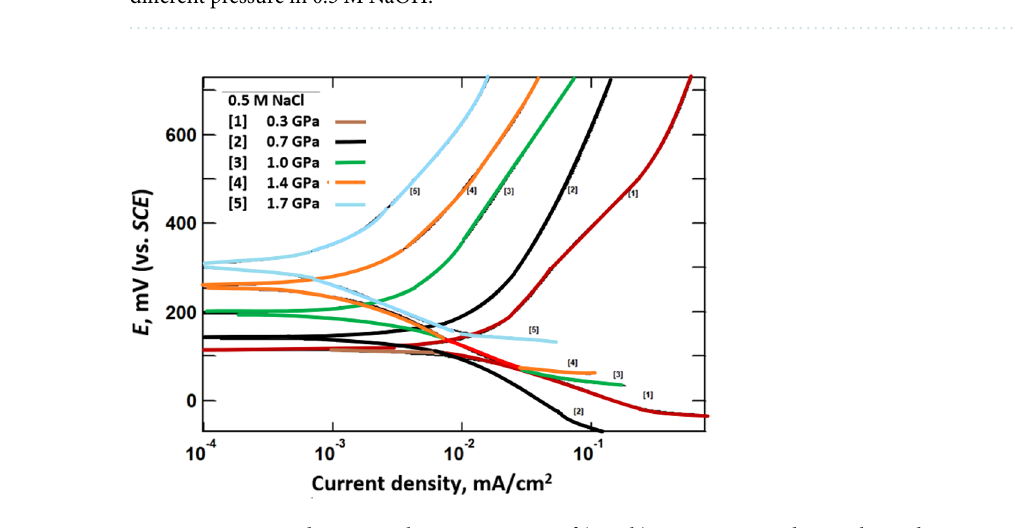
Figure 4. Potentiodynamic polarization curves of (Bi, Pb)-2223 superconductor electrodes compacted at different pressure in 0.5 M NaCl.